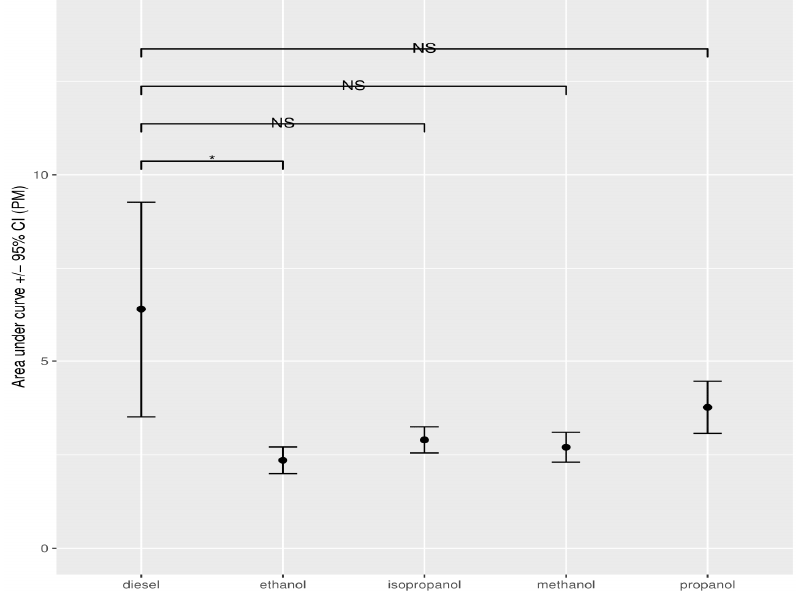
Figure 10. Error analysis bar chart of the concentration of PM, expressed as AUC, measured for the different alcohols between pure and diesel–alcohol mixtures. The dots show the mean AUC value, obtained through bootstrap resampling. Error bars indicate the 95% confidence interval around the mean. Asterisks show the significance of the pairwise comparison of the AUC values (* p < 0.05; NS: not significant).